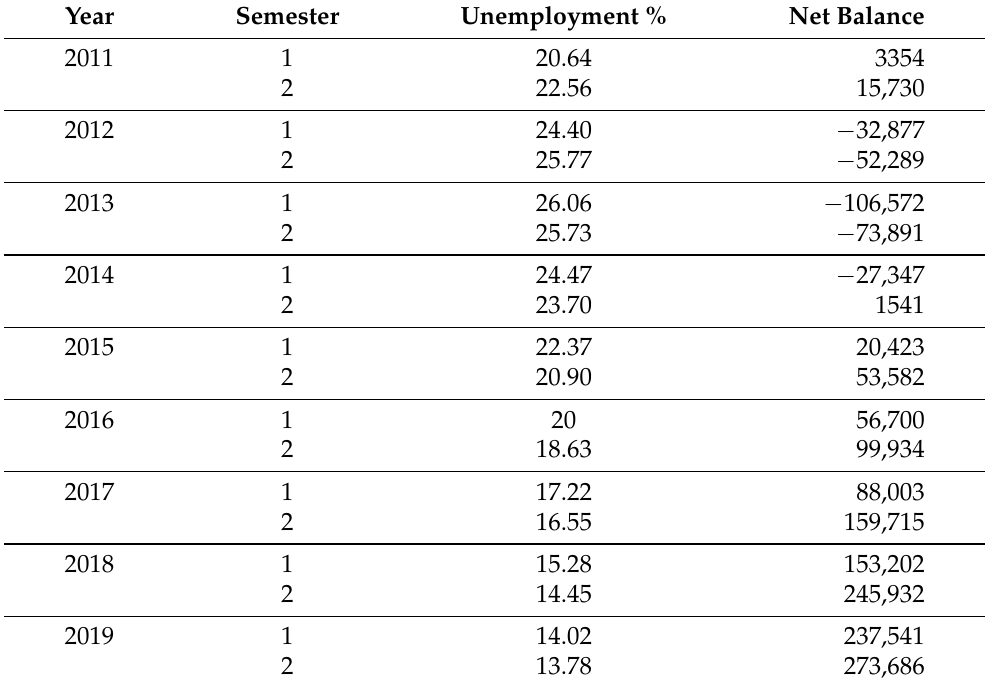
Table 2. Net Balance vs. Unemployment